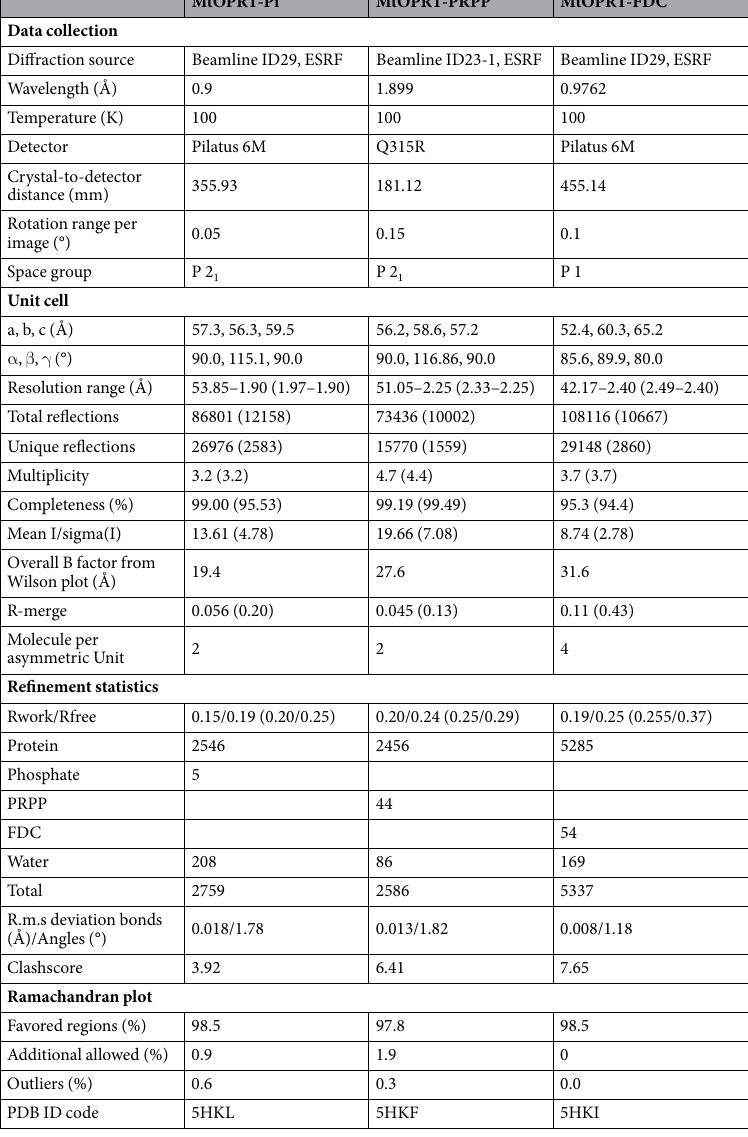
Table 3. Data collection and refinement statistics a . a Values in parenthesis are for the highest-resolution